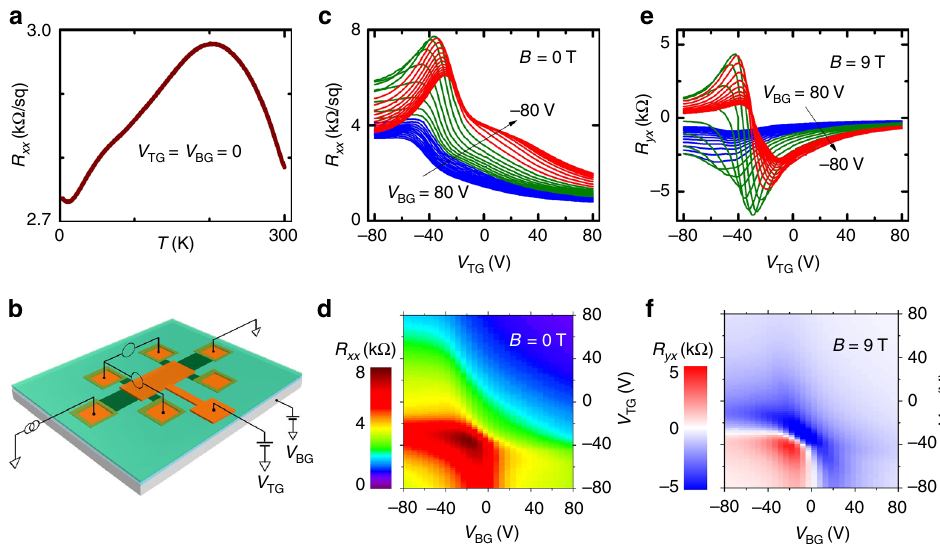
Fig. 1 Dual-gating of BST fi lms. a Temperature dependence of R xx in a 17-nm-thick device at zero gate voltages ( V TG = V BG = 0). b Schematics of the dual- gate Hall-bar device and the measurement con fi guration. c , d Gate – voltage dependencies of R xx in 0 T at 2 K. e , f Gate – voltage dependencies of R yx in the perpendicular magnetic fi eld of 9 T at 2